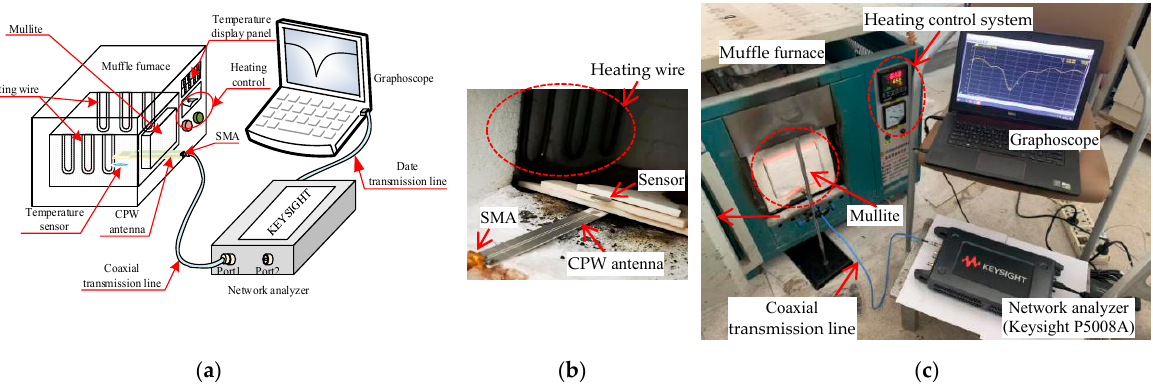
Figure 8. (a )High temperature environment test platform diagram (b) Experimental test diagram (c) Experimental test device 255 Figure 8. ( a ) High temperature environment test platform diagram, ( b ) experimental test diagram, ( c ) experimental test device.